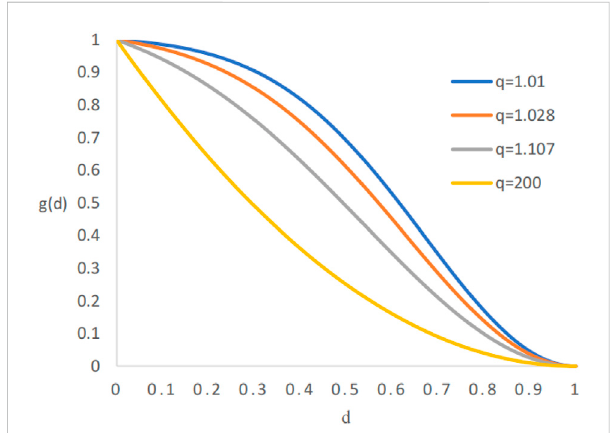
FIGURE 1 Shape of the proposed degradation function in this work. As the parameter q increases the degradation function approaches the standard quadratic, and as q decreases towards 1 the peak stress predicted by the model